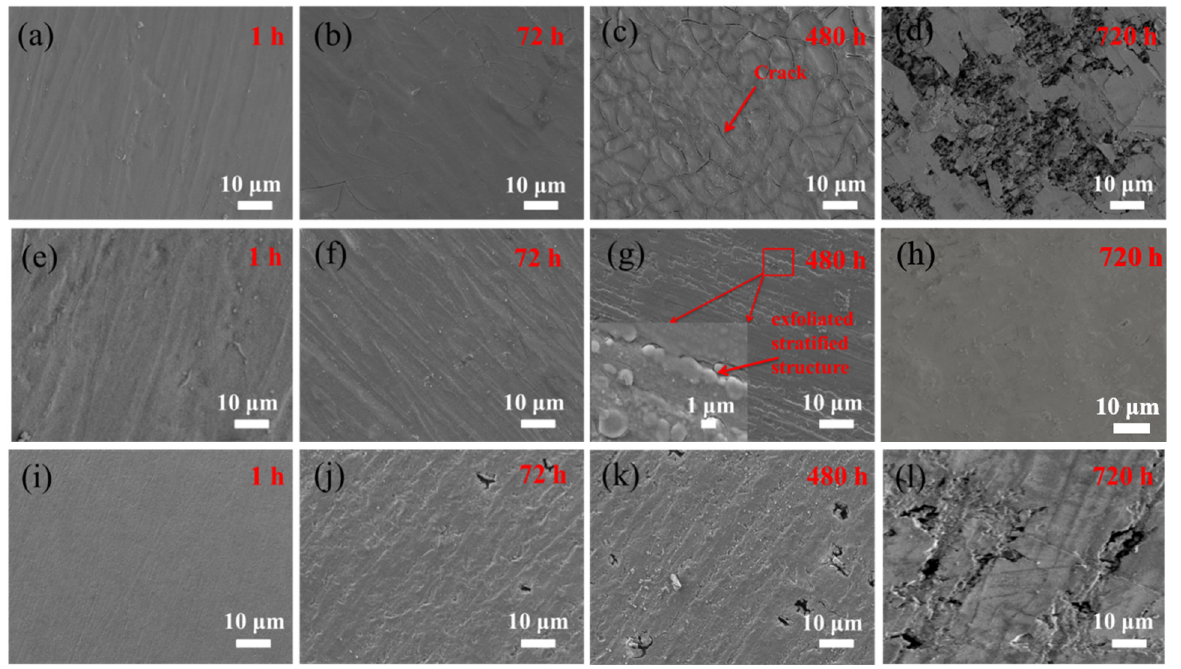
Figure 5. Surface morphology of ( a – d ) for SG film coated samples and ( e – h ) for SG/GO film coated samples and ( i – l ) for bare 5052 Al alloy after 1 h, 72 h, 480 h and 720 h immersion in 3.5 wt.% NaCl solution.